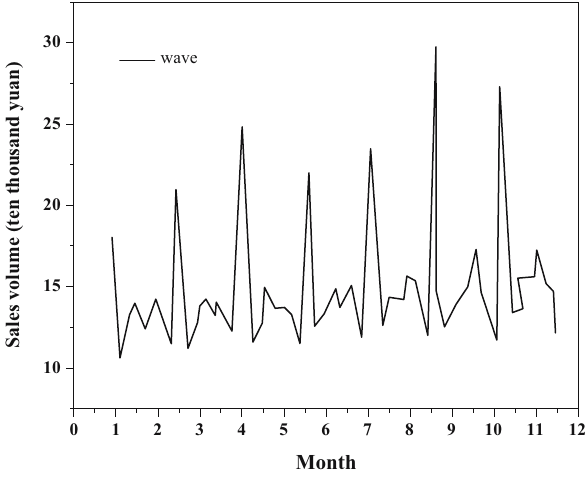
Figure 4: Scatter plot of monthly cigarette sales from 2015 to